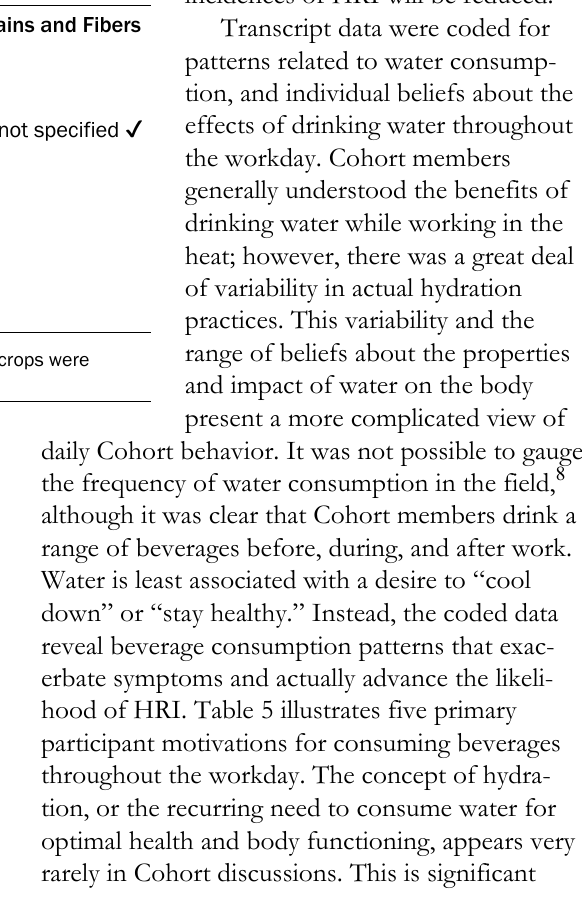
Table 4. Cohort Employment Status and Payment Schemes Employment Status, Pay